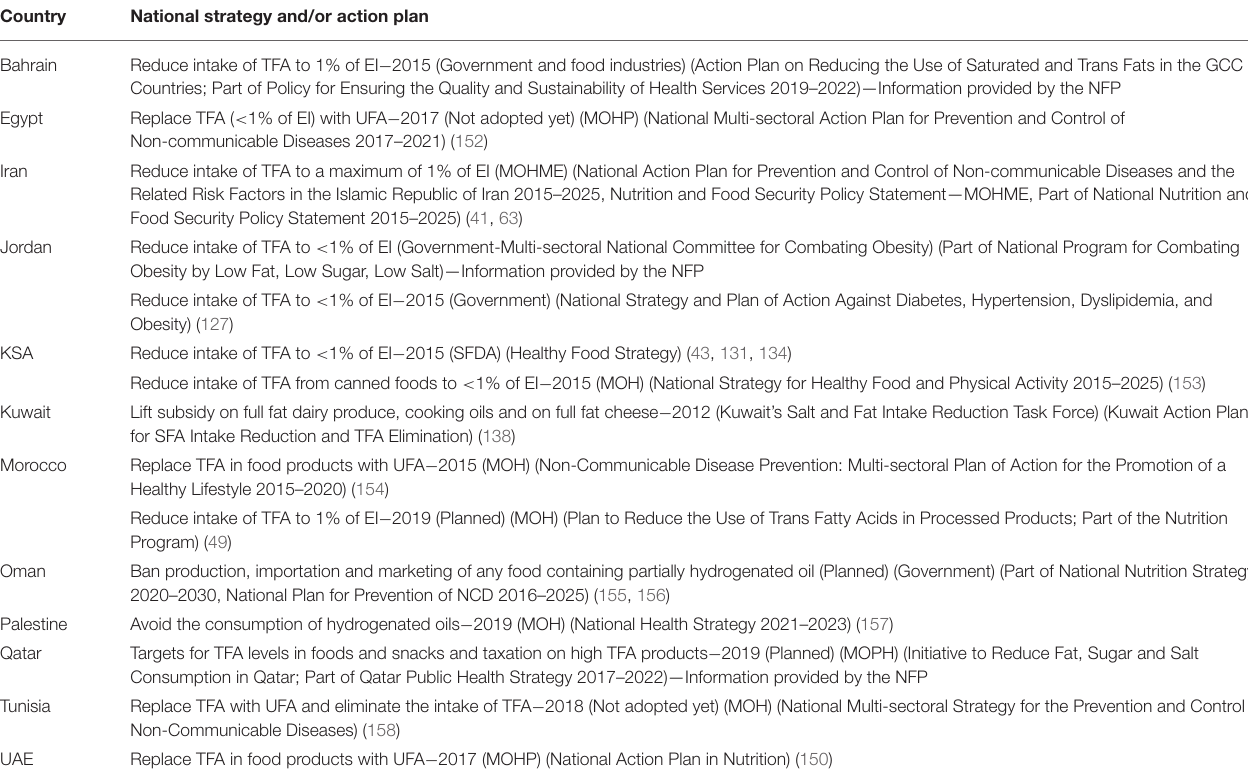
TABLE 2 | National TFA reduction strategies or action plans identified in the EMR countries. Country National strategy and/or action